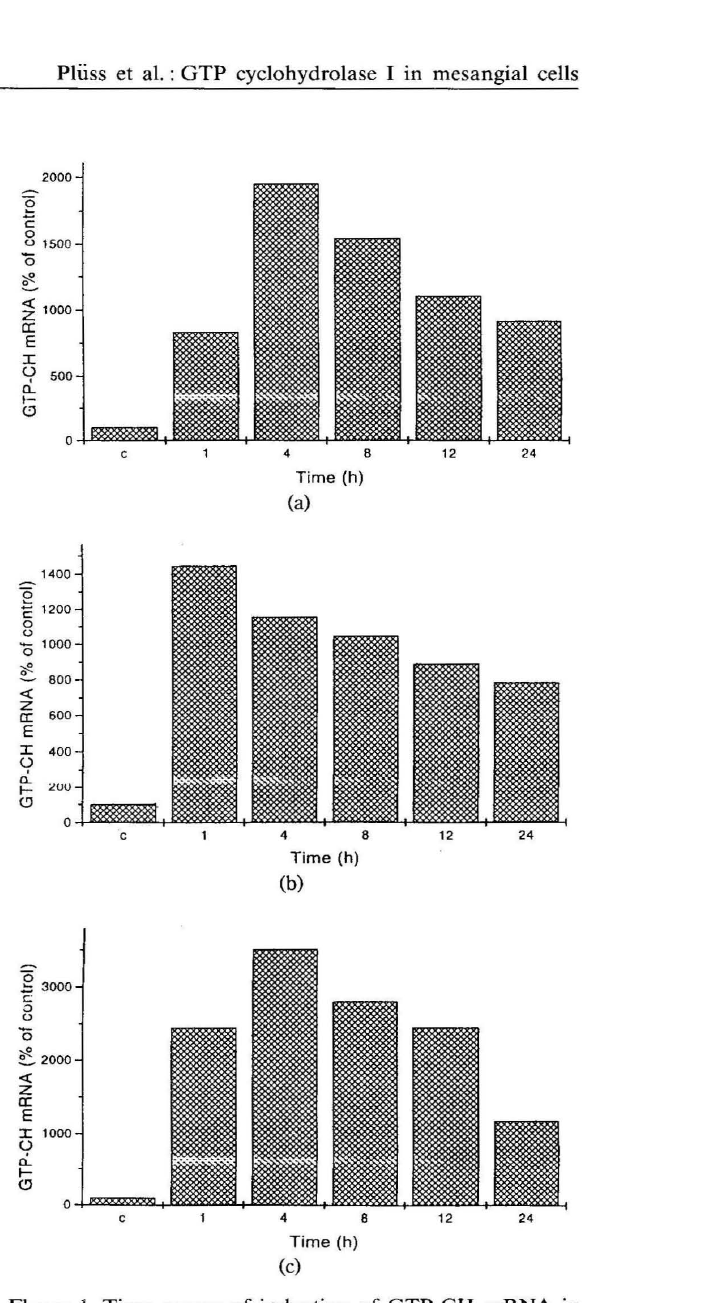
Figure 1. Time course of induction of GTP-CH mRNA in mesangial cells Mesangial cells were treated with IL-I ~(2 nM) (A) Bt2 cAMP (O.SmM), (B) or a combination of IL-I~ (2 nM) plus forskolin(lO 11M) (C) for the indicated time per iods. RNA was extracted and GTP-CH mRNA was quan tified by nuclease protection assay as described in Materials and